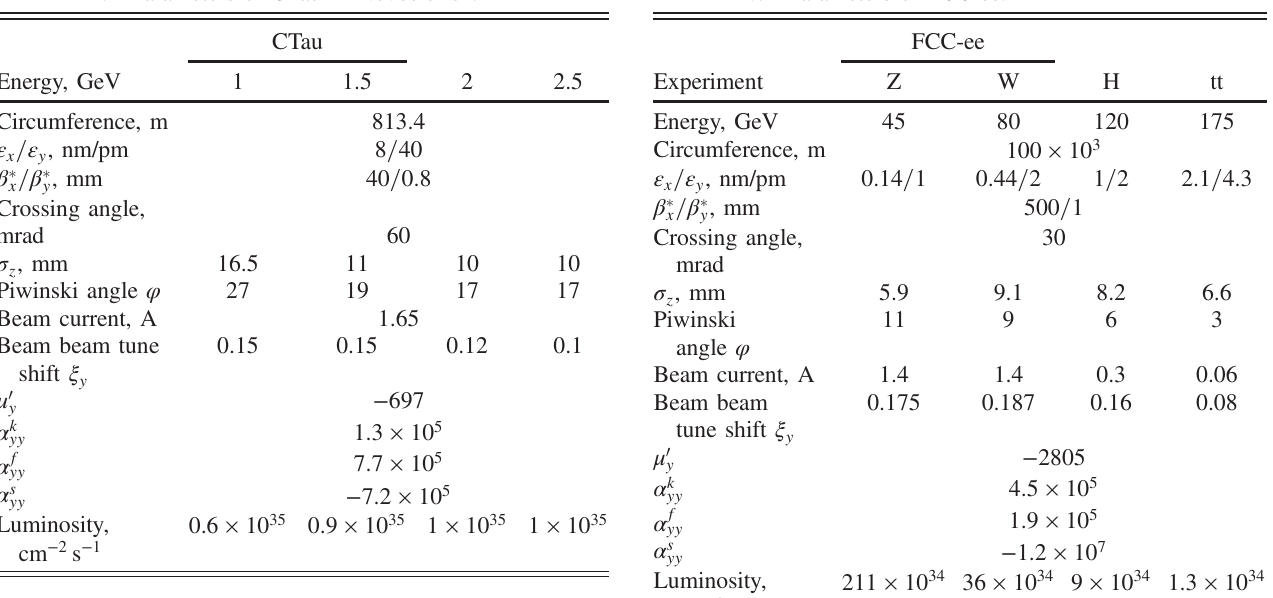
TABLE IV. Parameters of FCC-ee.